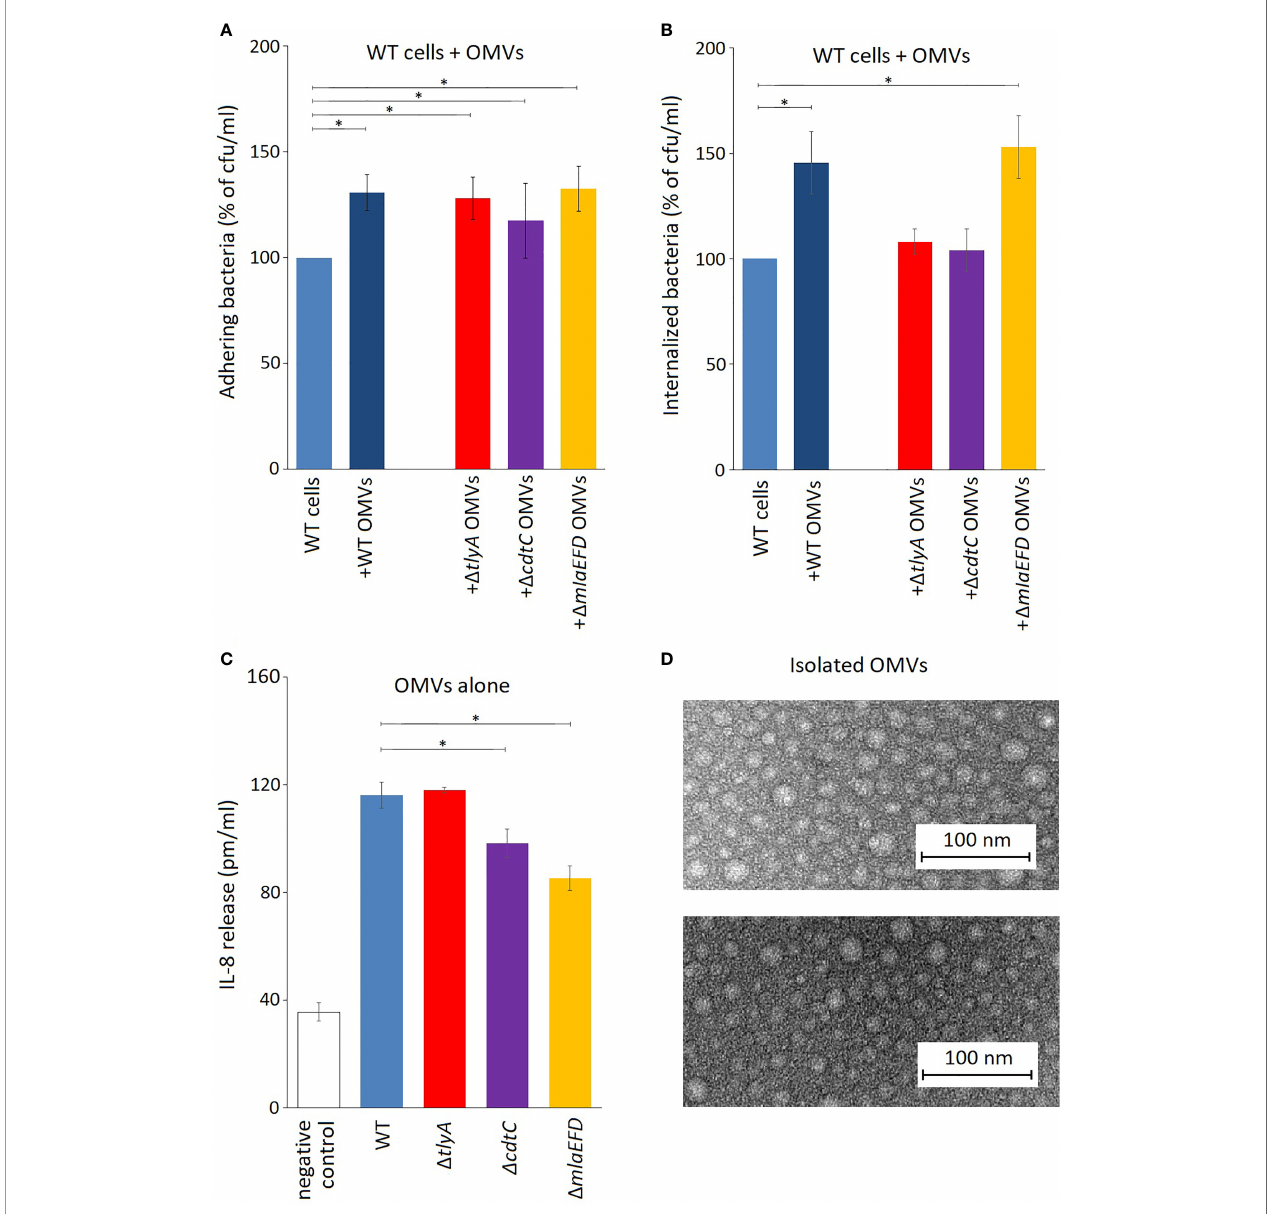
FIGURE 4 | OMVs produced by C. jejuni strains. (A) In fl uence of C. jejuni OMVs on adhesion to epithelial cells. Puri fi ed OMVs (10 m g) from the various strains were added to viable wild-type C. jejuni and incubated for 2 h with Caco-2 cells. Addition of OMVs isolated from wild-type and mutant strains signi fi cantly increased adhesion of C. jejuni to Caco-2 cells (*P < 0.05). (B) OMVs from the wild-type and D mlaEFD strains (added and incubated as in panel A) signi fi cantly improved internalization of wild-type C. jejuni into Caco-2 epithelial cells (*P < 0.05). No signi fi cant change in C. jejuni internalization was observed with OMVs from the D tlyA